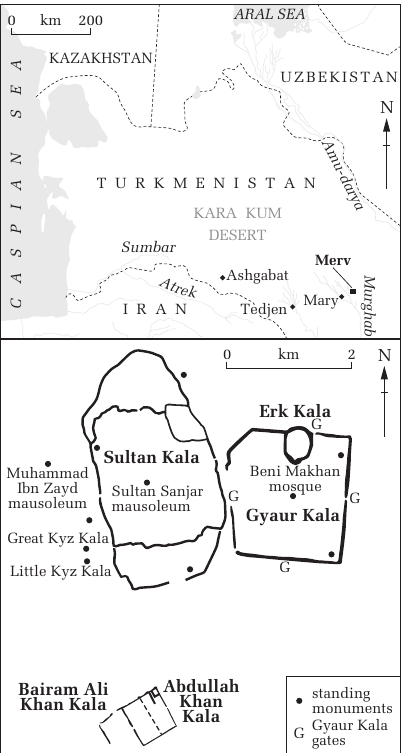
Figure 1 The location of Merv in